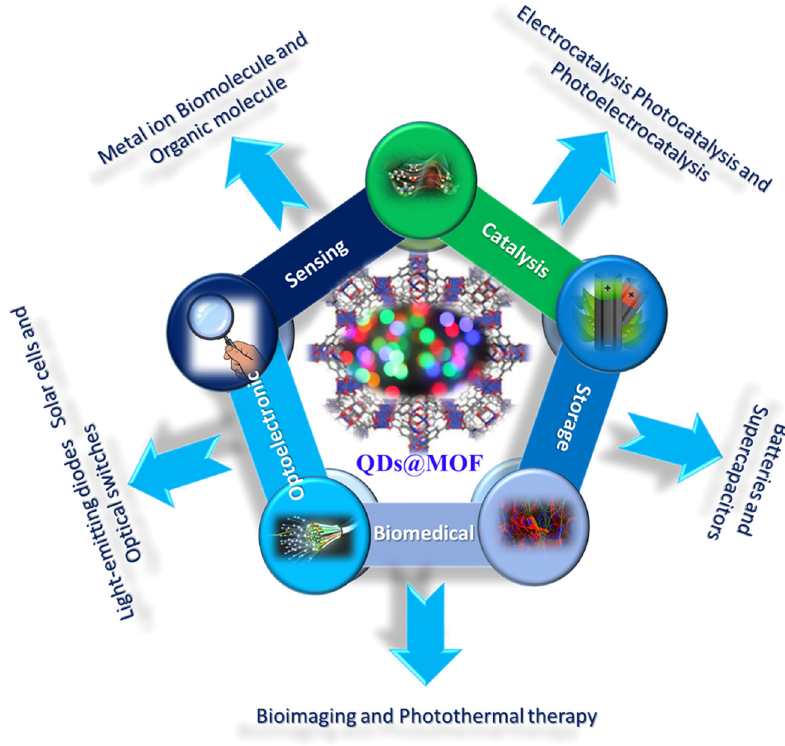
Figure 4: A schematic representation of QDs@MOF for various captivating